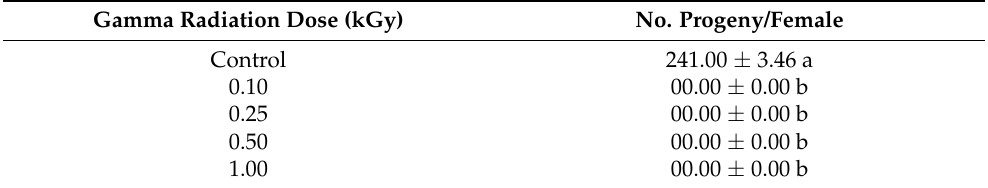
Table 4. Effect of different doses of gamma radiation on progeny production of S. oryzae after 60 days of